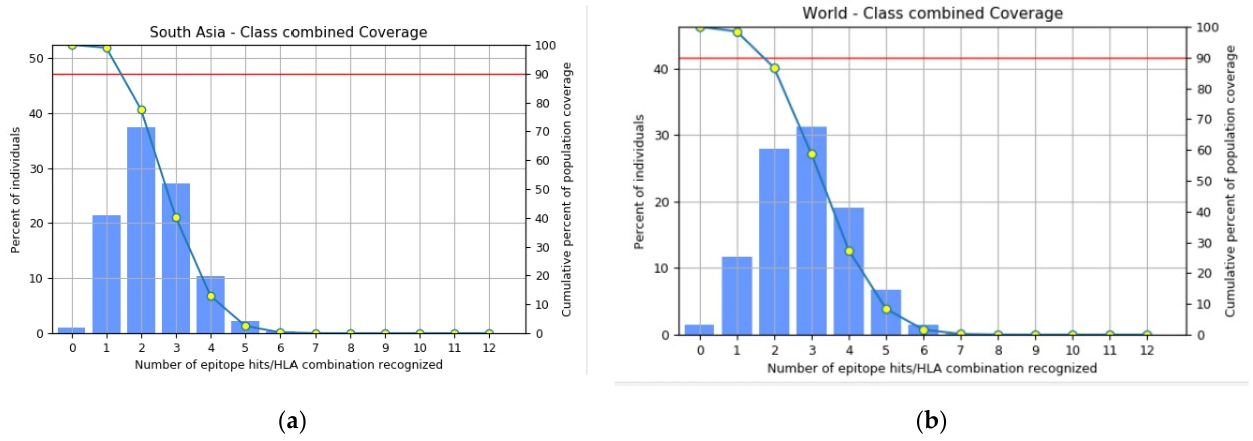
Figure 4. Percent class combined coverage of vaccine construct in ( a ) South Asia population and ( b ) worldwide population Table 2. Population coverage of the vaccine construct.